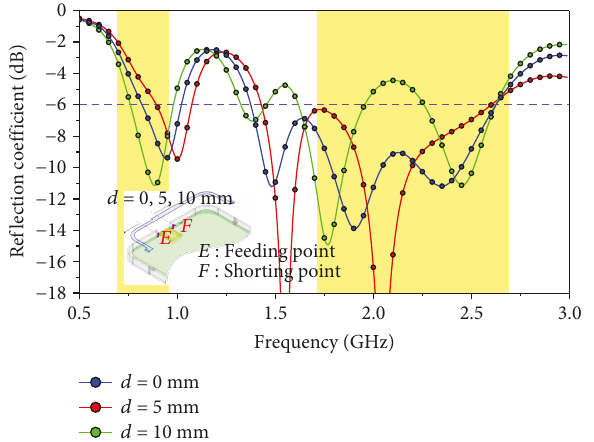
Figure 6: Reflection coefficient of the proposed antenna as a function of the